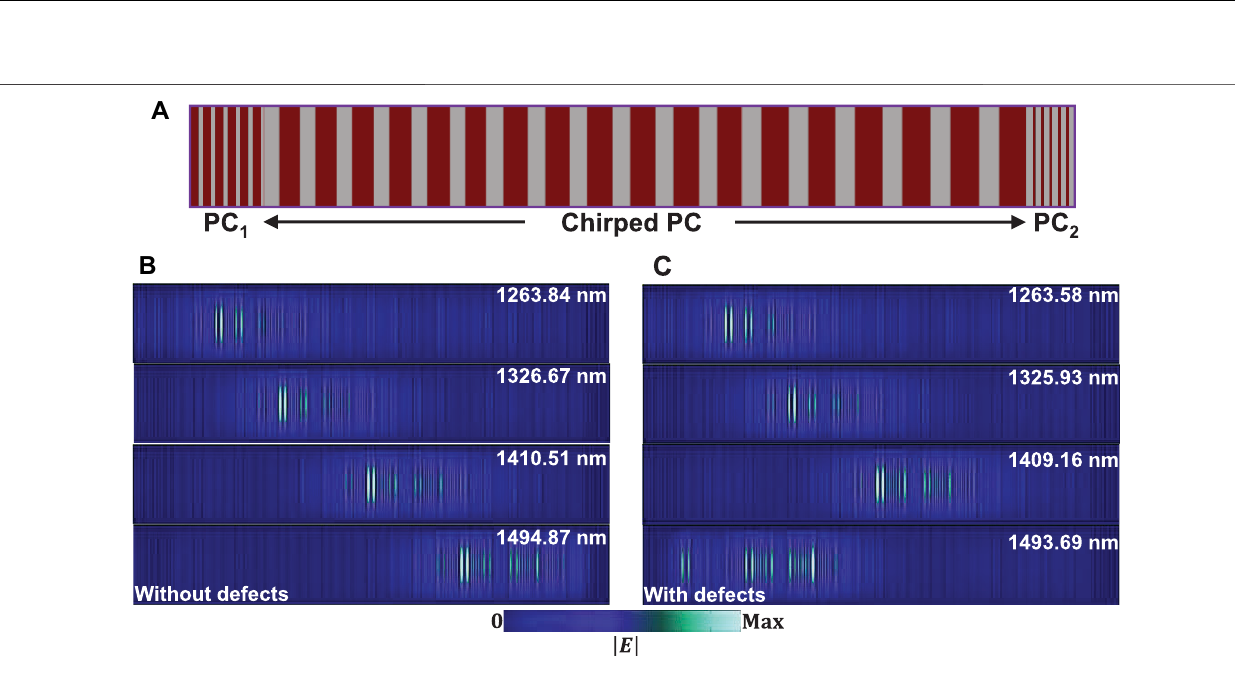
FIGURE6|(A) Schematicdiagram ofthechirpedPCsandwiched betweentwoPCs.The|E| intensity distribution ofthetrivialunidirectional rainbow trappingof18 periodsofthetrappedchirpedPCbetweenPC 1 andPC 2 (B) withoutdefects; (C) withdefectsbythedisorderingofsomeparameters(deformationinlastand fi rstlayers of PC 1 and PC 2